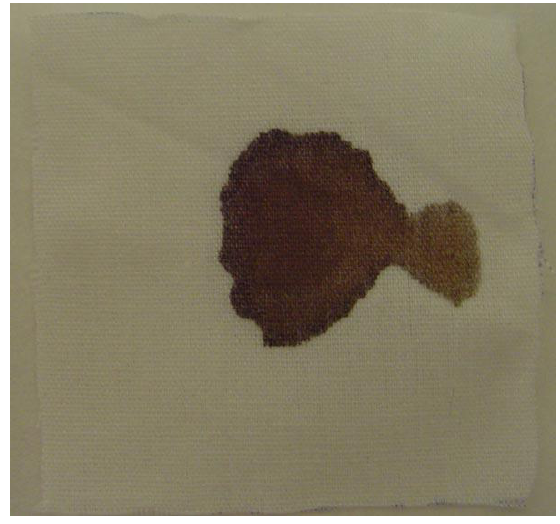
FIGURE 1. Bloodstain before washing.